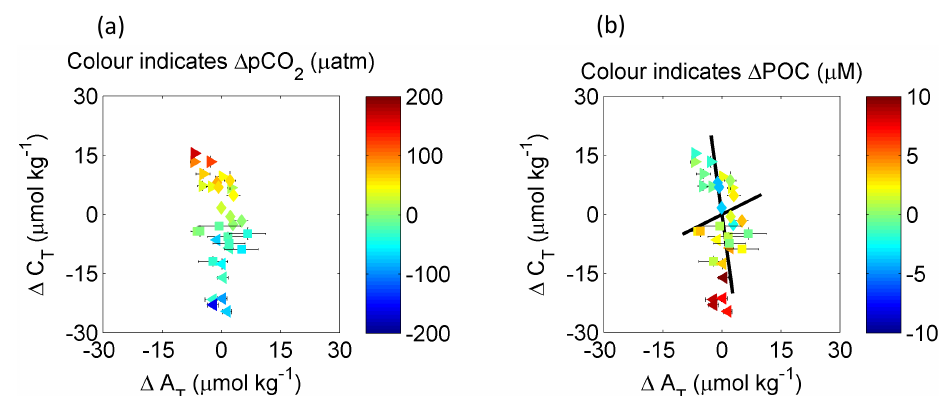
Figure 5. Scatter plots of differences between initial condition and time point samples ( 1 ) for the main experiments excluding E1 (i.e. E2–E5). 1C T (µmolkg − 1 ) is plotted against 1A T (µmolkg − 1 ) with calculated changes in p CO 2 ( 1p CO 2 ) (µatm) and measured changes in POC ( 1 POC) (µmolL − 1 ) indicated by colours in the left and right panel, respectively. Symbol shapes indicate experiments as in Fig. 3. Plotted values are means ± 1 SE. Black lines in (b) correspond to the predicted influence of production and remineralisation of organic material and